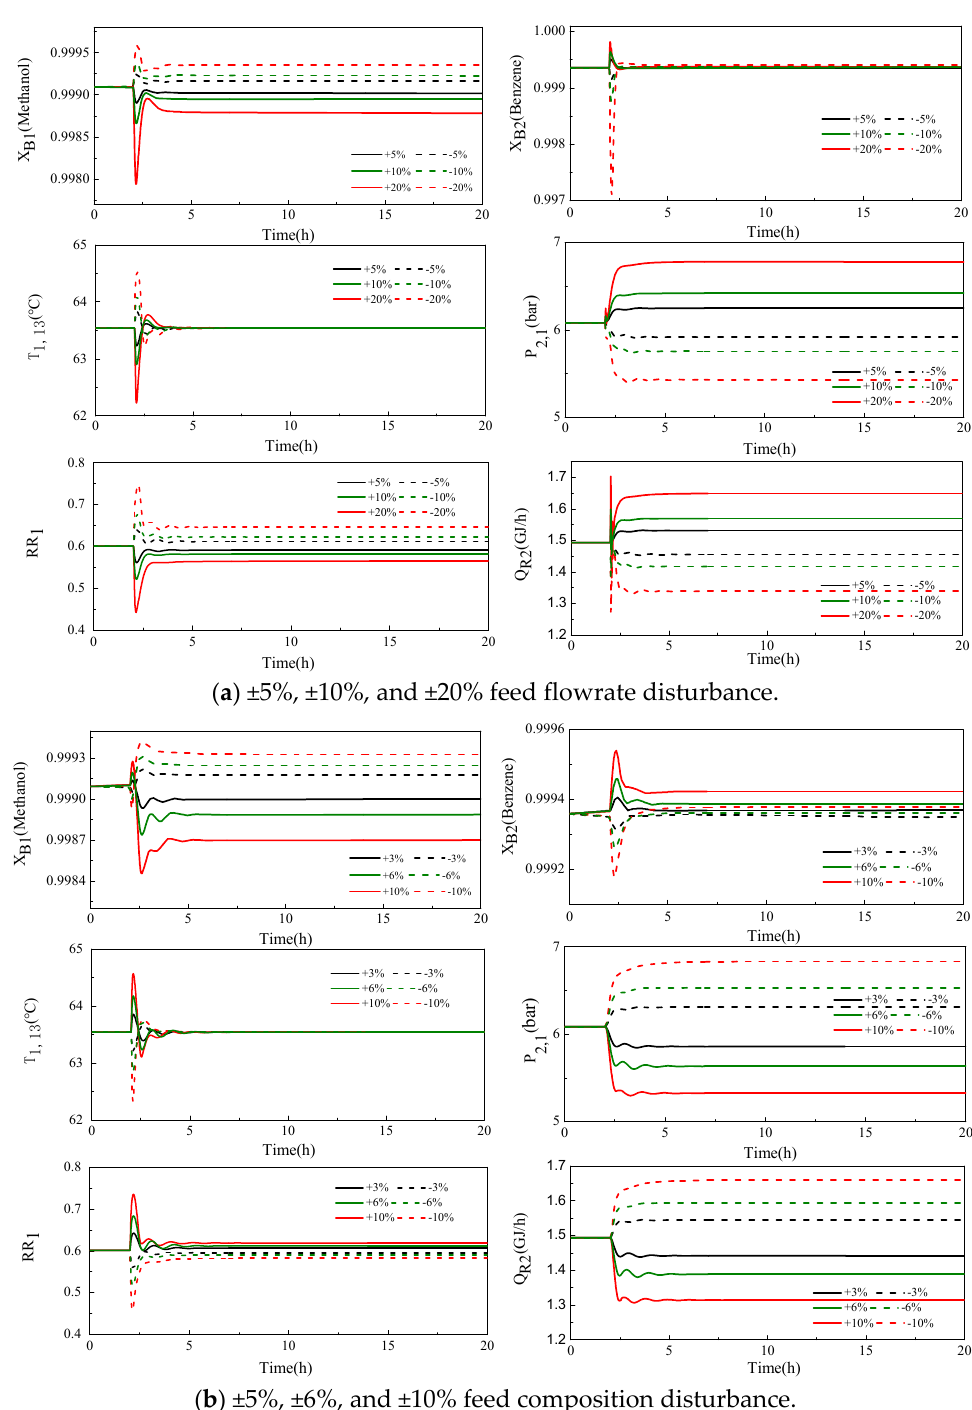
Figure 19. The dynamic responses of pressure-compensated temperature control structure.